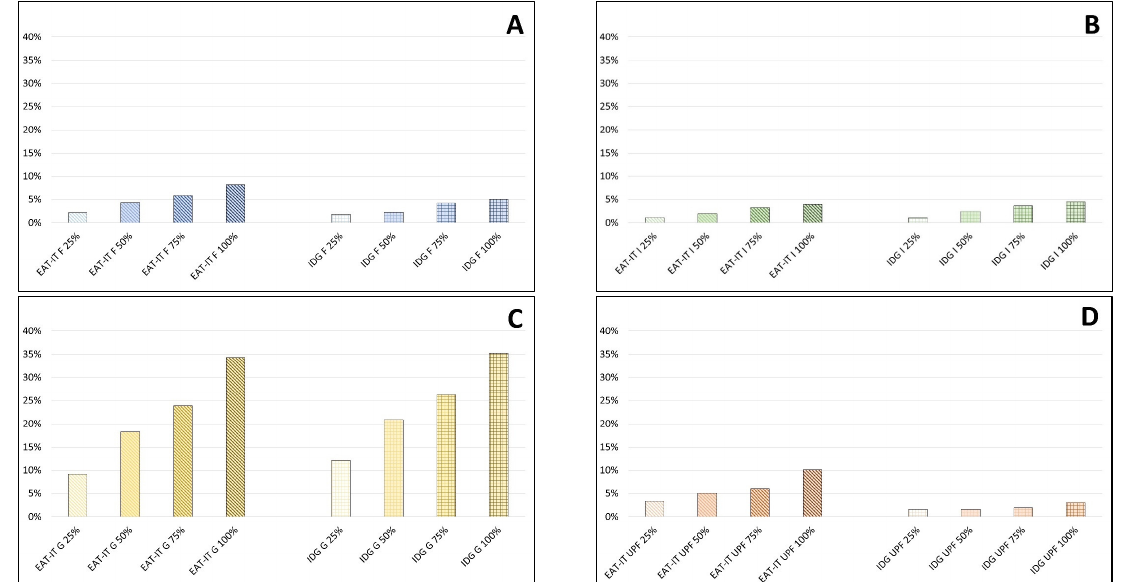
Figure 4. Impact of different food choices on CF and WF case-studies with a gradual increase in the substitution of frozen instead of fresh foods ( A ), imported instead of local fruits ( B ), greenhouse-grown instead of seasonal vegetables ( C ), and processed legume-based foods instead of unprocessed legumes ( D ). Data are expressed as delta percentage compared to the EAT-IT and IDG dietary patterns .